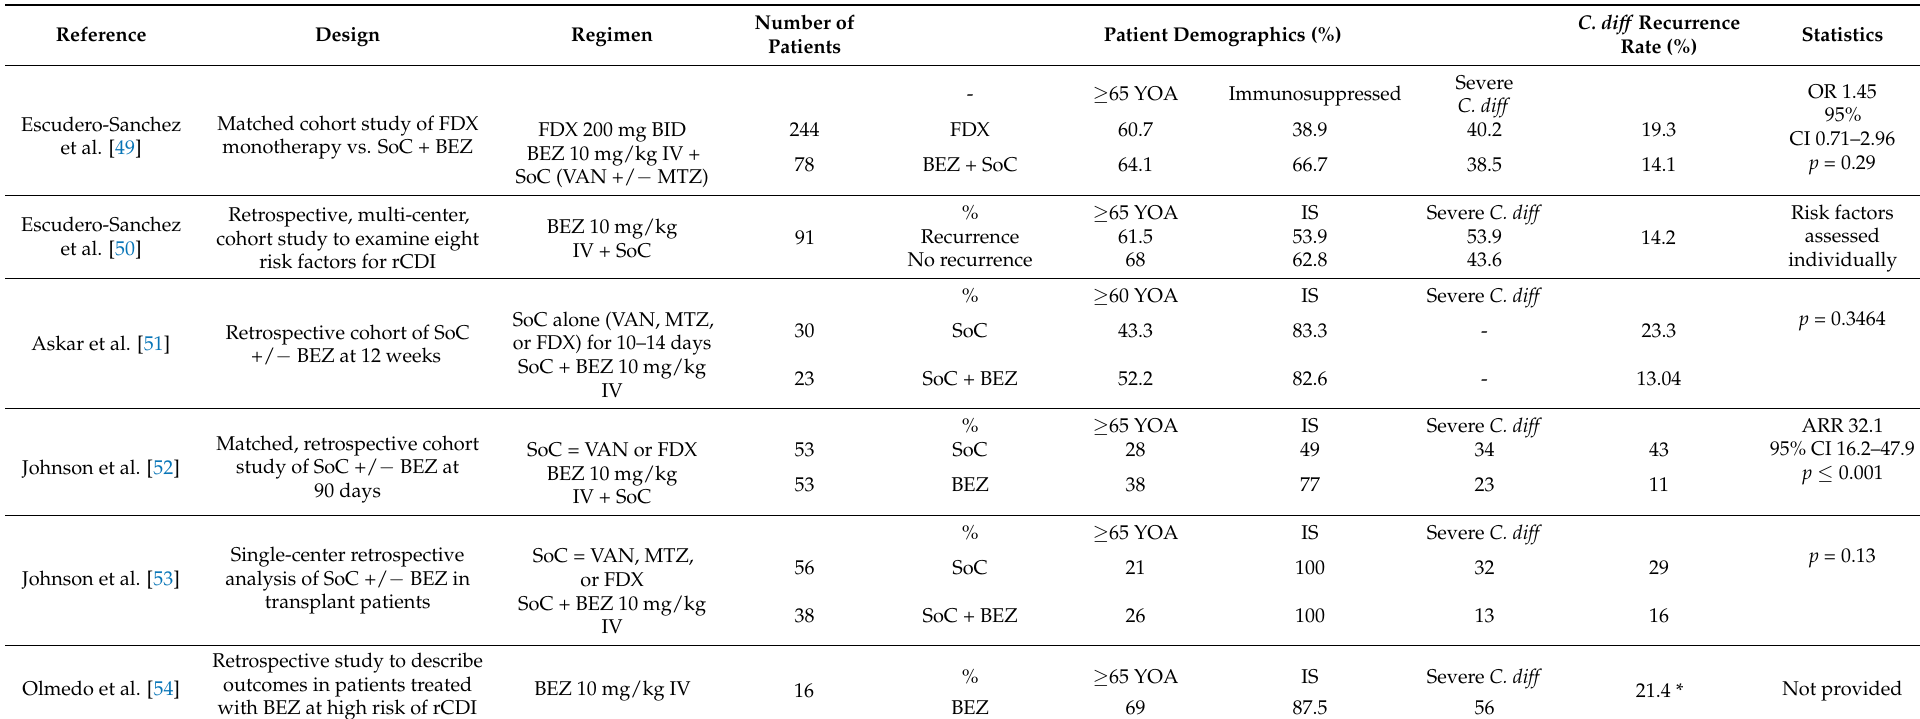
Table 4. Highlights of Real-World Trials with Bezlotoxumab